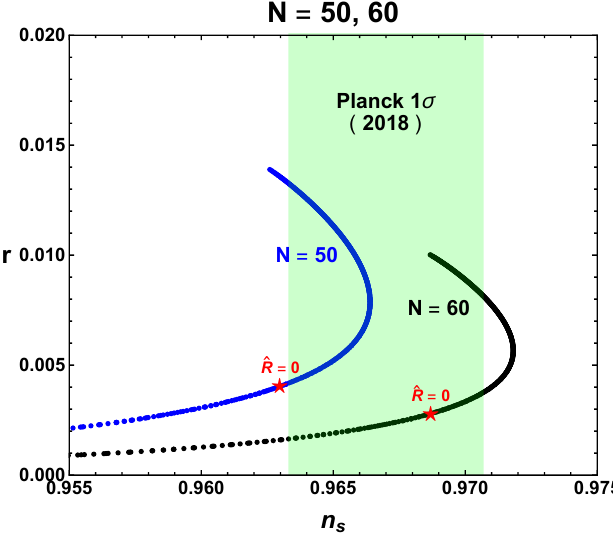
Figure 2 . Spectral index n s vs tensor-to-scalar ratio r between ^ R = (cid:0) 0 : 5 and 1 : 5. We have chosen N = 50 ; 60 in blue and black lines, respectively. Planck 1 (cid:27) band is shown in green. Star points correspond to the case with ^ R =